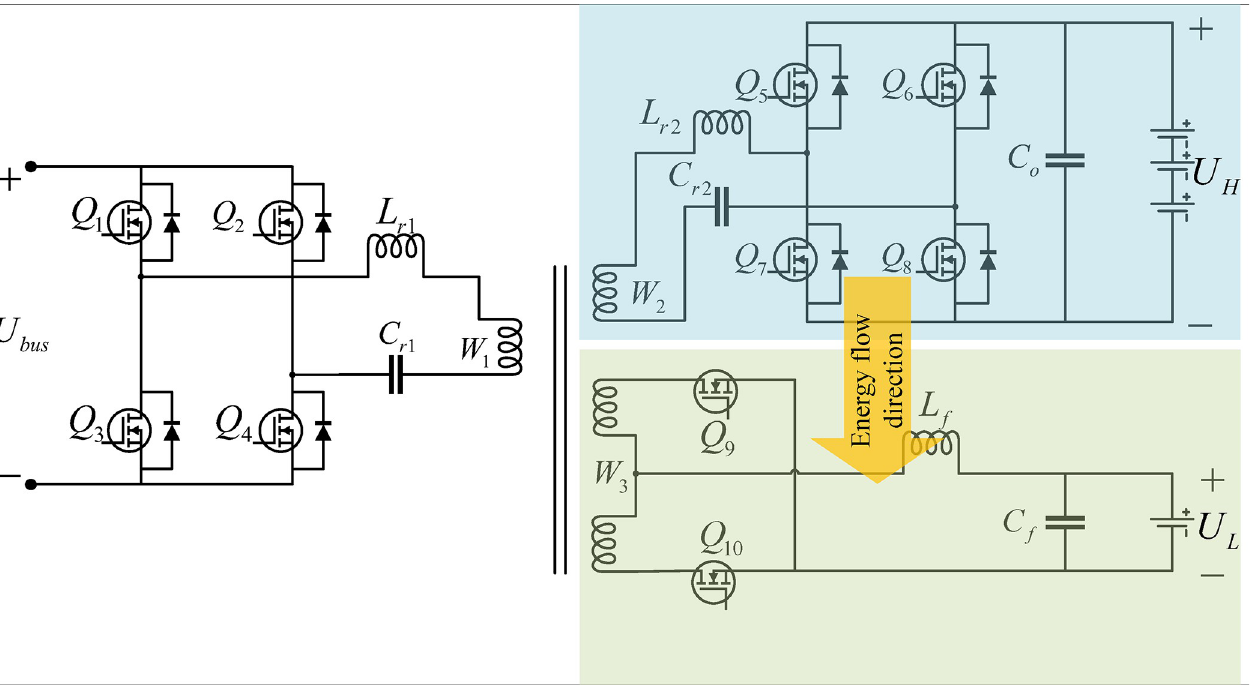
Fig 4. Driving charging